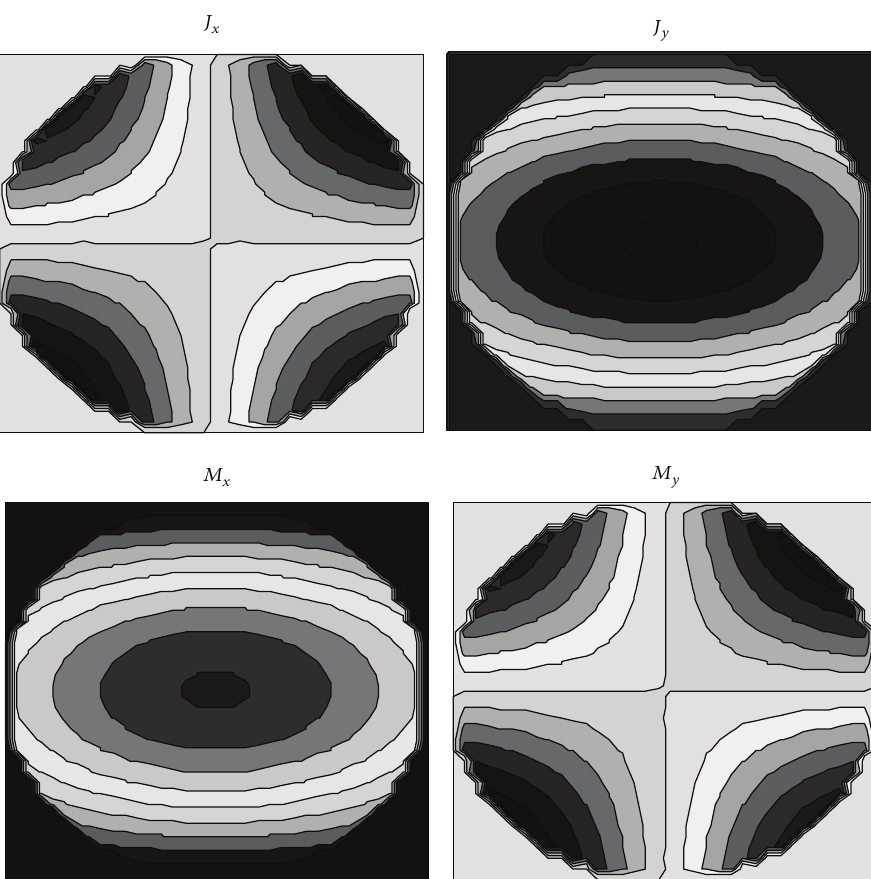
Figure 3: Current distribution over aperture of circular